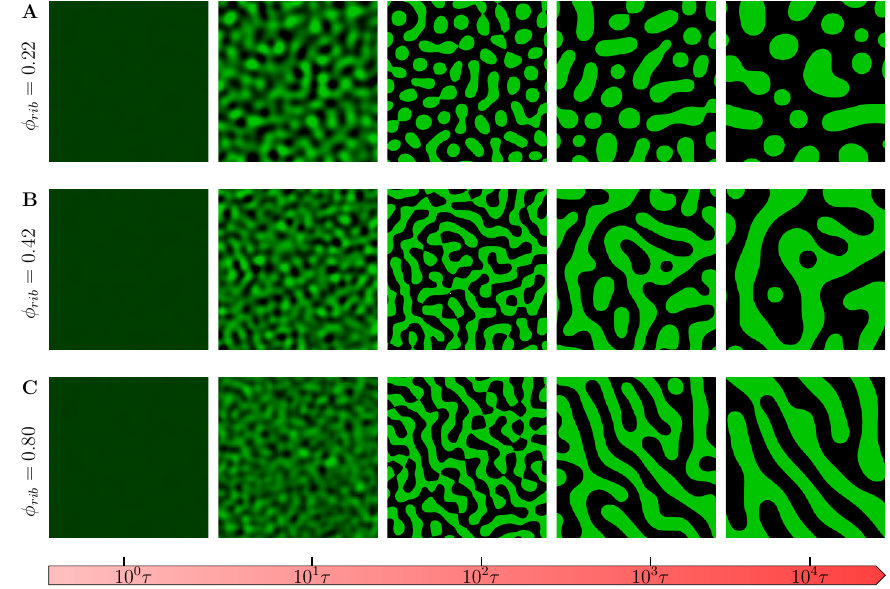
( φ ) = 0 for selected R (cid:54)